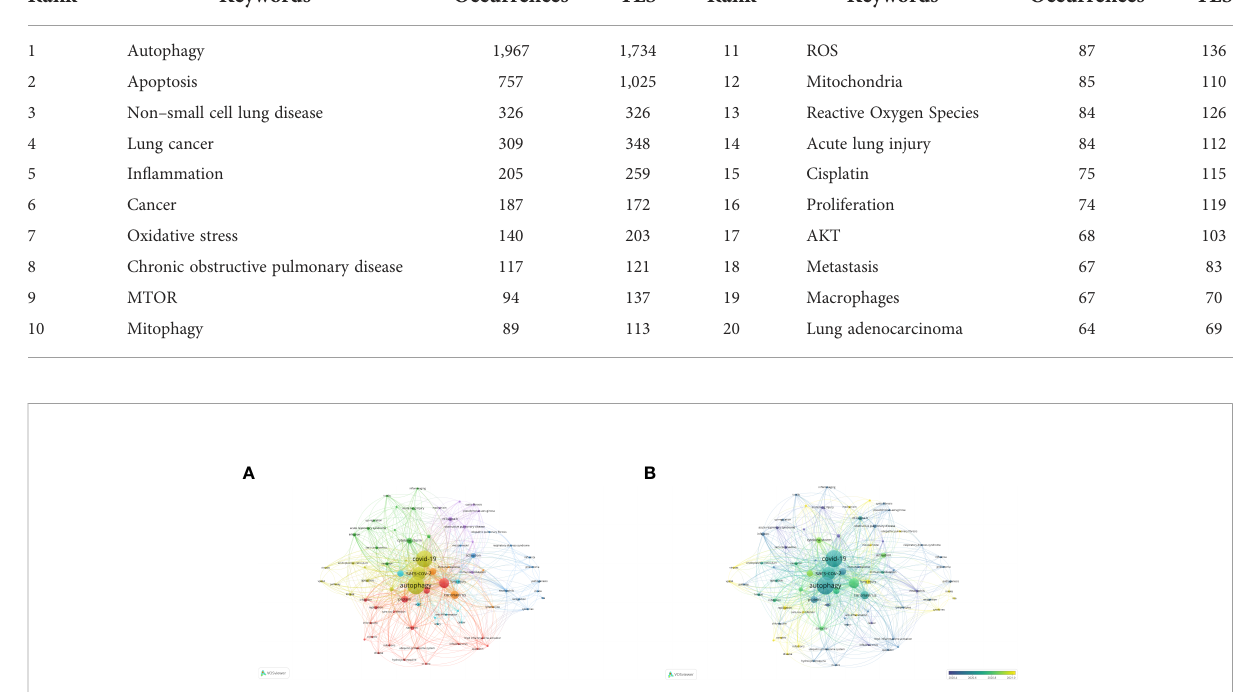
FIGURE 10 Visualization analysis of autophagy research in lung disease resulted from COVID-19. (A) Keyword network mapping. A total of 76 keywords appearing for over two times fell into six clusters based on colors. (B) APY-based keyword visualization. Keywords in yellow occurred later than those in blue (color version can be found online).